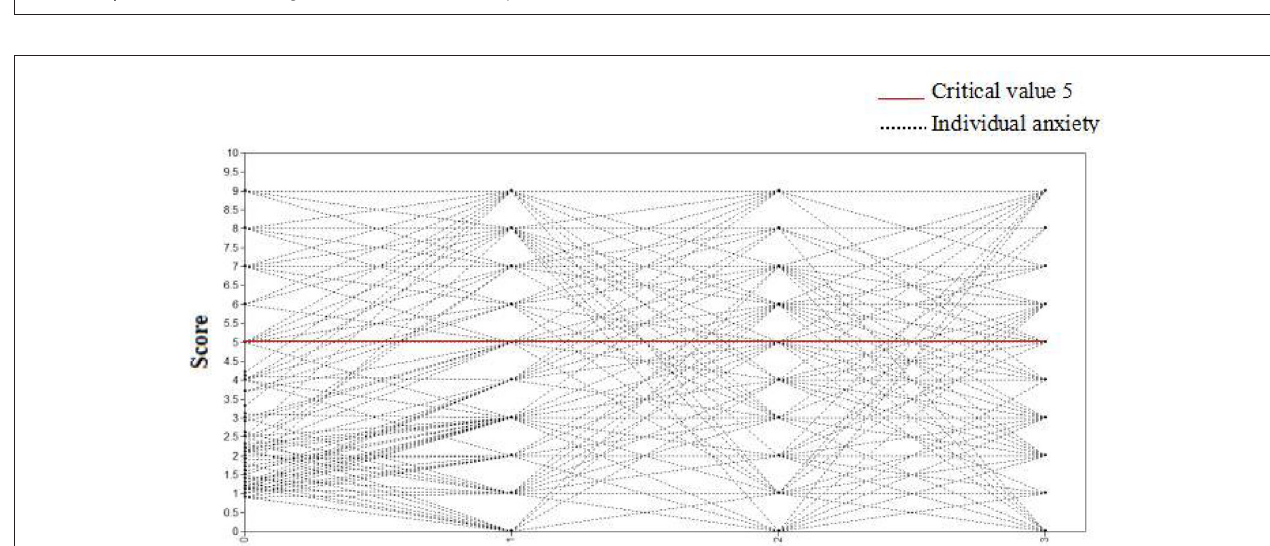
FIGURE 6 | Path of latent variable growth curve model of anxiety of medical staff.